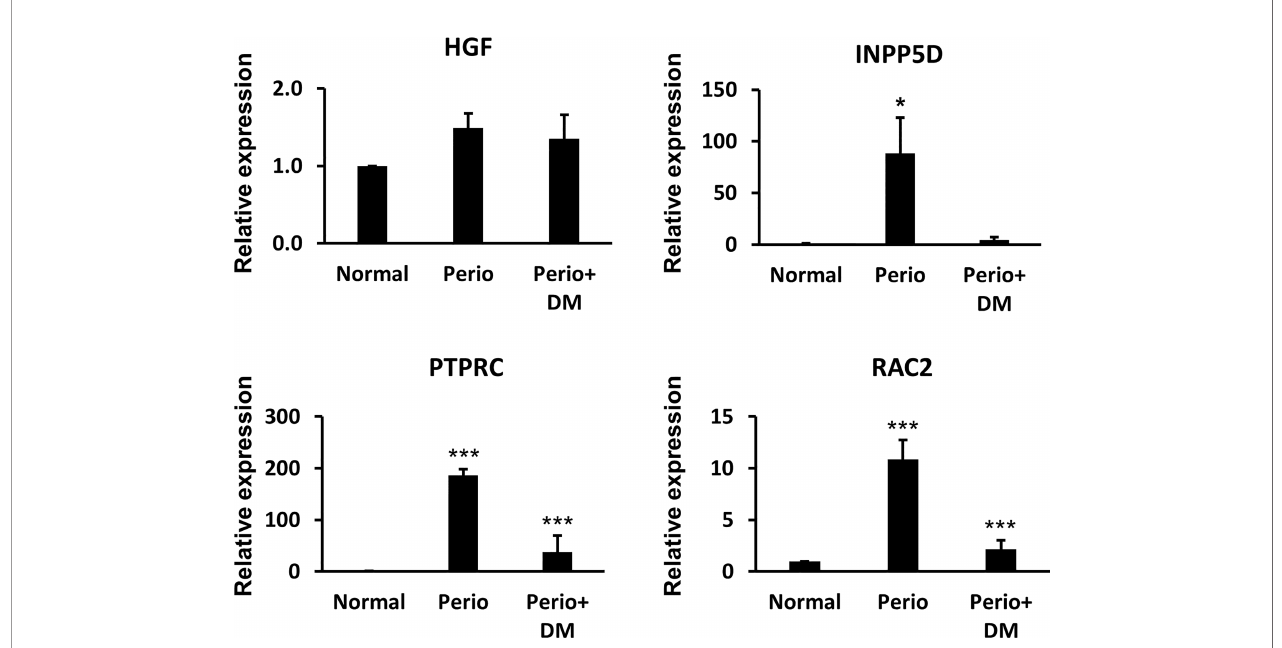
FIGURE 4 | The results of Quantitative reverse transcription-PCR between healthy controls, periodontitis patients, and periodontitis patients with diabetes. *p < 0.05, ***p <